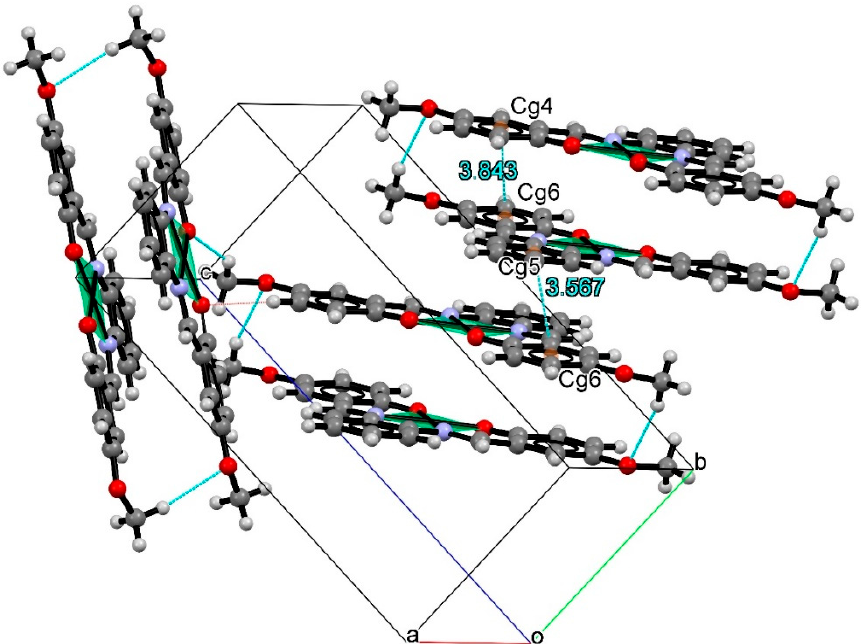
Figure 6. Crystal array of compound NiMeO salphen . View is a tridimensional perspective emphasizing R 22 (30) and R 22 (11) motifs and π -stacking.